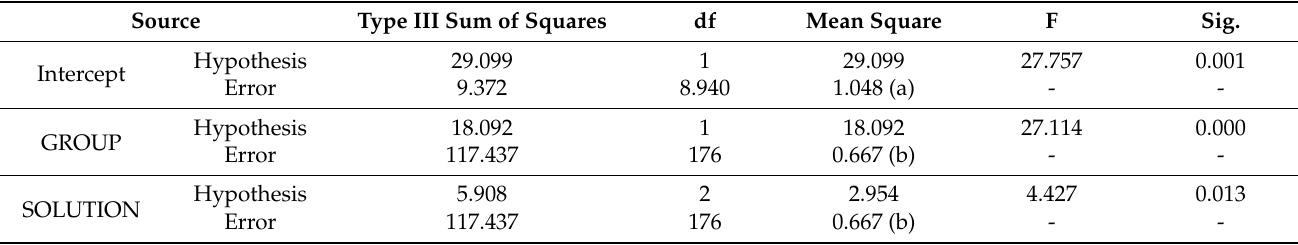
Table 3. Two-way ANOVA for mean color change among the four groups. Dependent variable: ∆ E 00 . df—degrees of freedom, F—ratio of two variances, Sig.—statistical significance.